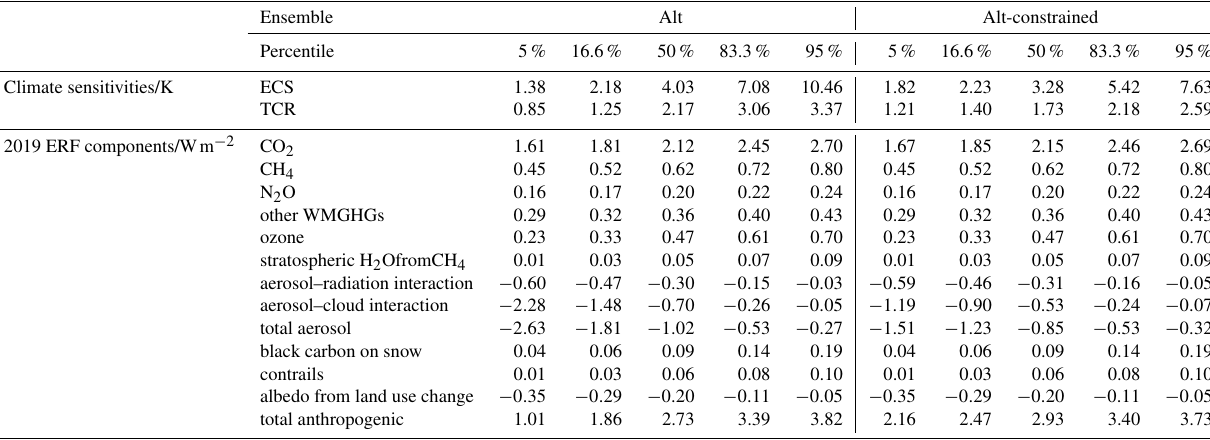
Table 8. Results for the key metrics under a less-informed climate sensitivity prior. Ensemble Alt Alt-constrained Percentile 5% 16.6% Climate sensitivities/K 2019 ERF components/Wm − 2